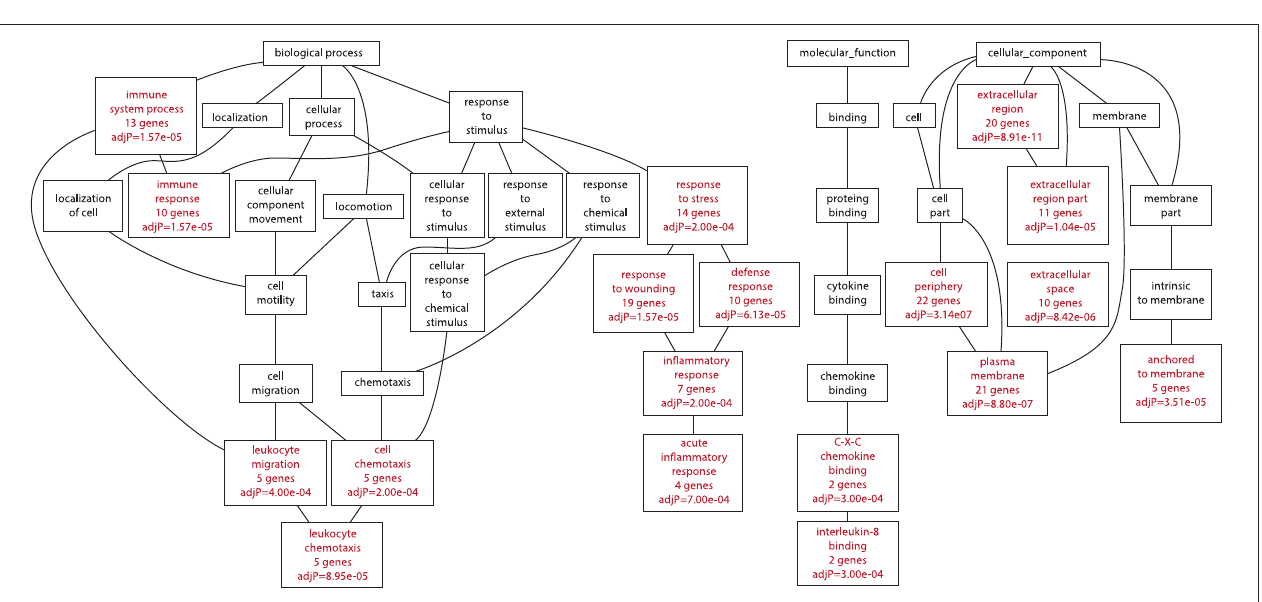
FIGURE 7 | Representative images of histopathological findings in animals infected by strain 48 and strain 48V. (A) Lung tissue from animal infected by strain 48 at day 14 postinfection, with formation of small granulomas and perivascular inflammation (arrow) (100X magnification). (B) Lung tissue from animal infected by strain 48V at day 14 postinfection shows scarce interstitial inflammation without granuloma formation (100X magnification). (C) Animals infected by strain 48 had small pneumonic and necrotic areas throughout the lung tissue by day 21 postinfection (25X magnification). (D) Animals infected by strain 48V developed large confluent areas of pulmonary necrosis by day 21 postinfection (25X magnification). Stained with hematoxylin and eosin.